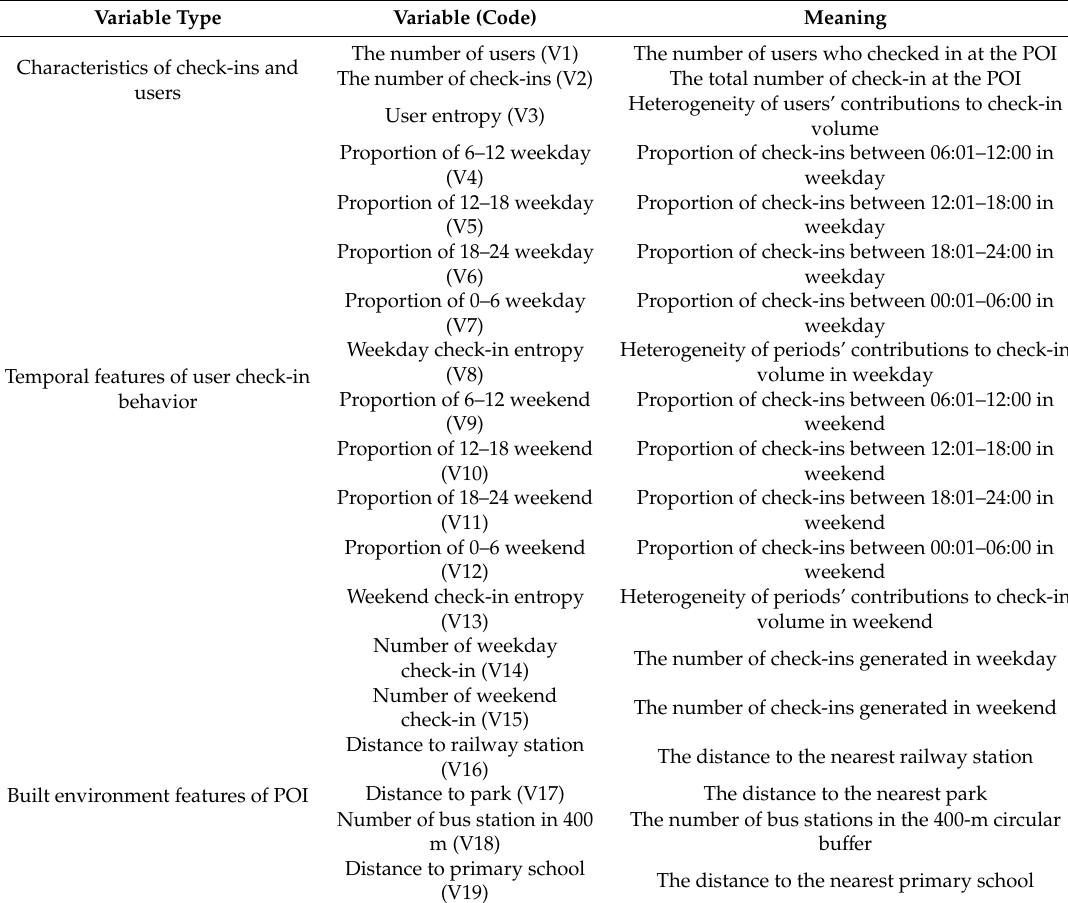
Table 2. Explanatory